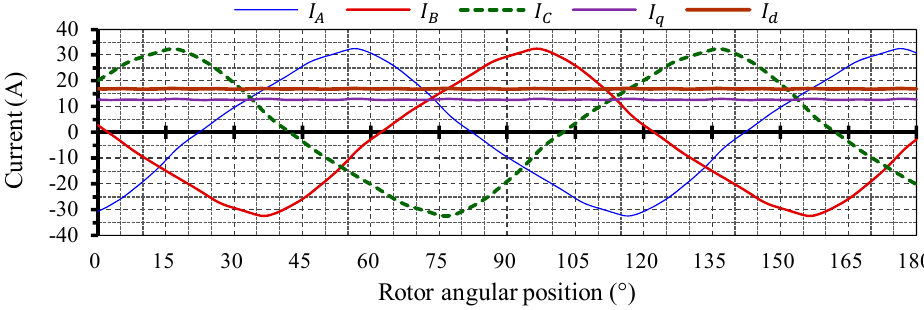
Figure 14. Full-load armature currents and the components of quadrature and direct-axis currents. The electromagnetic torque, the three-phase output power (instantaneous power), and its average value are shown in Figure 15. The average value of the electromagnetic torque is 131.6 N ⋅ m, and the average value of the instantaneous power is 13.22 kW, as presented in Table 6. The ratio between the maximum oscillation and the average value is